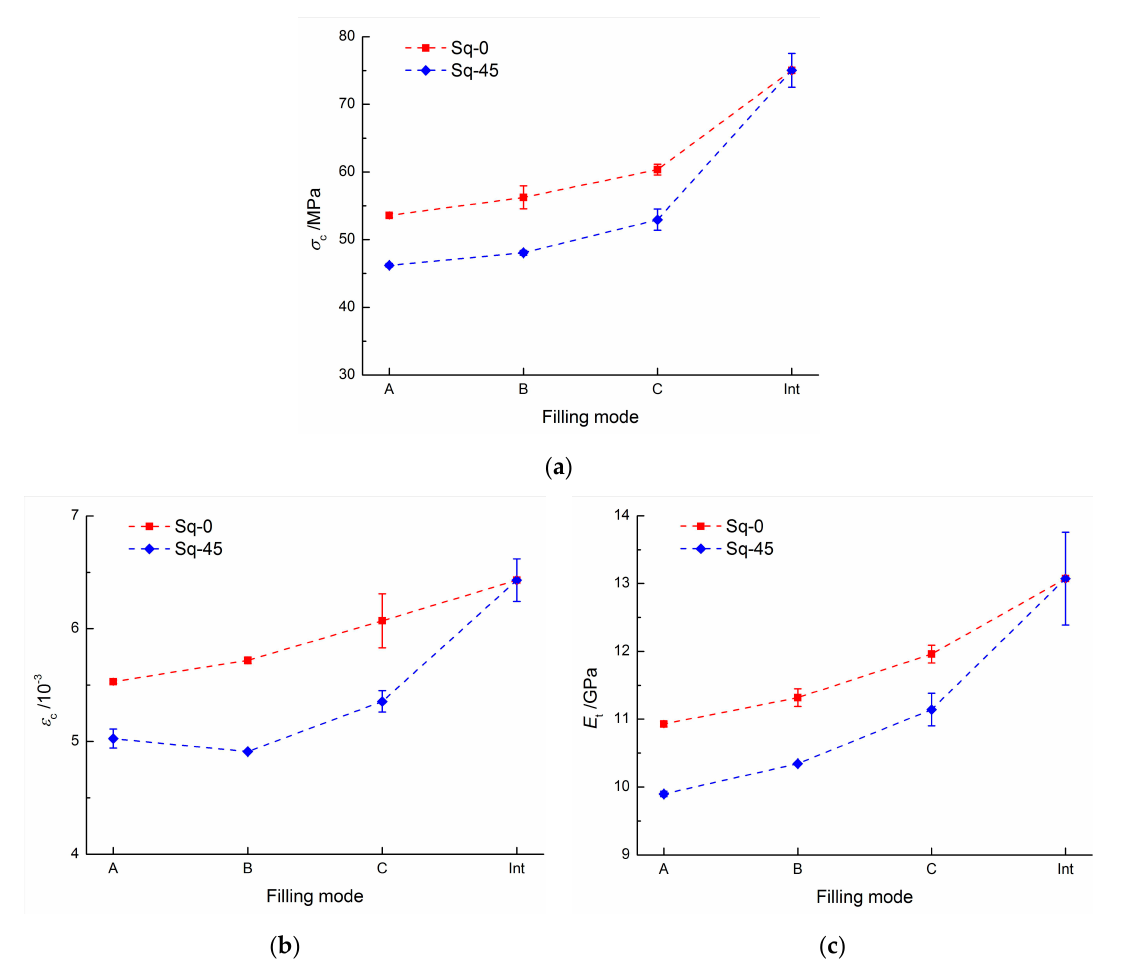
Figure 6. Effect of filling mode and hole angle on the mechanical parameters of specimens: ( a ) peak strength σ c ; ( b ) peak strain ε c ; and ( c ) elastic modulus E t .